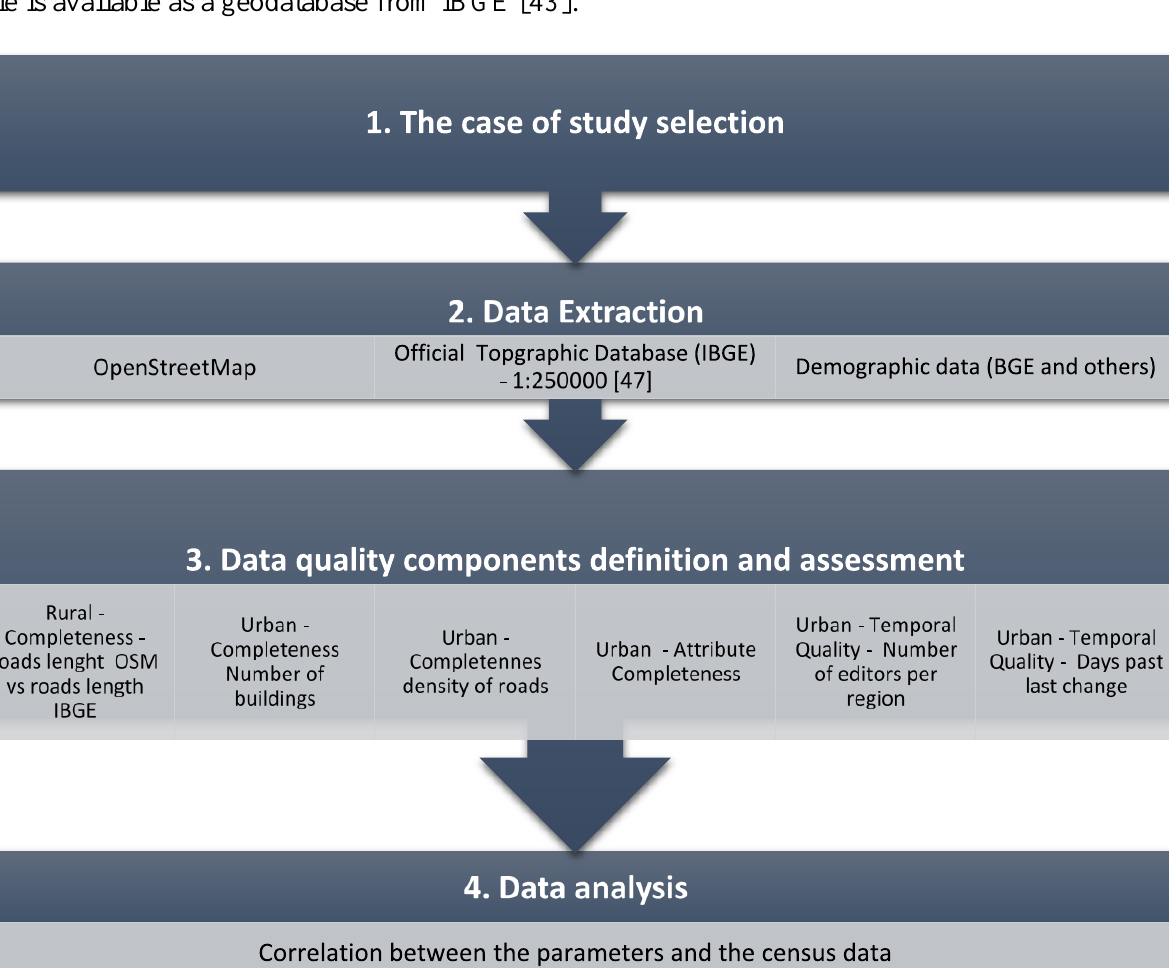
Figure 5. Workflow